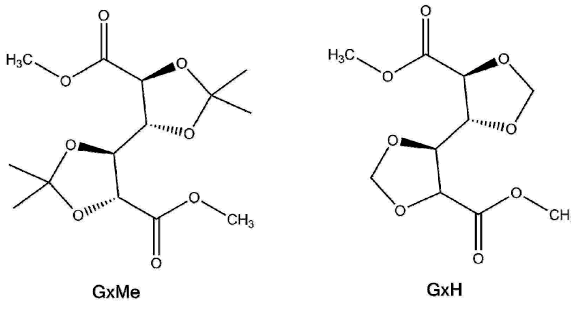
Figure 1. Chemical structure of the two acetalised galactarate esters: dimethyl-2,3:4,5-di- O - isopropylidene-galactarate (GxMe) and dimethyl-2,3:4,5-di-methylene-galactarate (GxH).